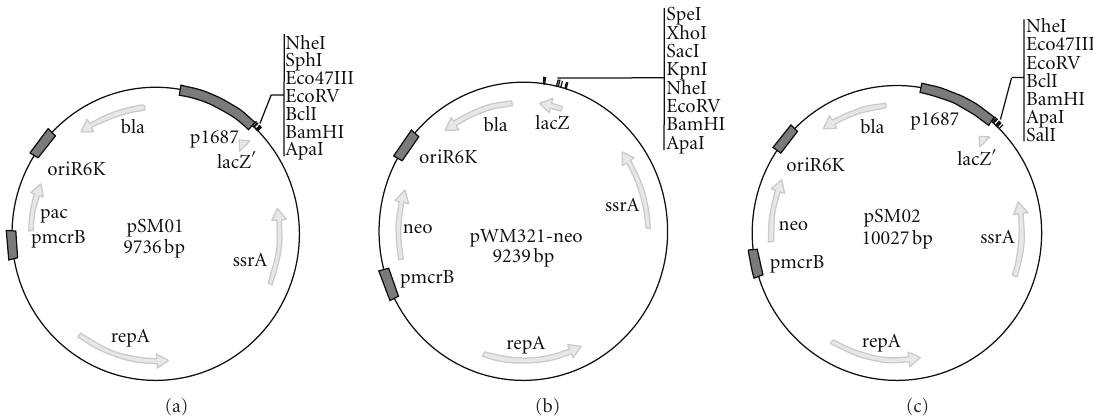
Figure 1: Maps of the plasmids constructed during this study. (a) Plasmid map of pSM01 that is a pWM321 derivative containing in addition the p1687 promoter for inducible protein production. (b) Plasmid map of pWM321-neo that contains the resistance cassette (neo) for neomycin resistance instead of the pac gene. (c) pSM02 is a combination of pSM01 and pWM321-neo. It contains both the neomycin resistance cassette and the p1687 promoter for inducible protein